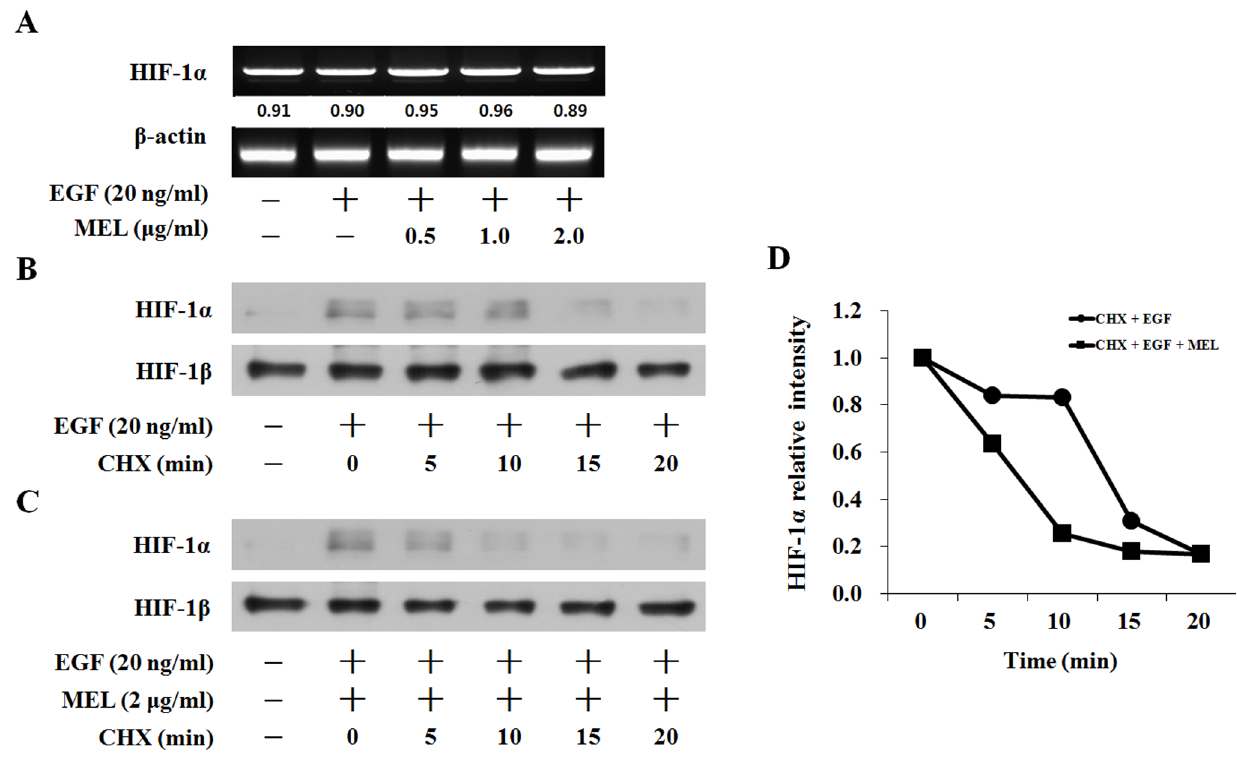
Figure 2. Melittin (MEL) inhibited the HIF-1 a expression by decreasing its stability. (A) RT-PCR analysis of HIF-1 a mRNA was carried out using total RNA prepared from CaSki cells incubated with EGF treatment for 12 h in the presence or absence of the indicated concentrations of MEL. (B) Cells were pretreated with the indicated EGF for 6 h, and then were treated to CHX time-dependent. (C) Cells were pretreated with the indicated EGF for 6 h. After 6 h, it was cotreated to MEL and CHX (10 m M) time-dependent. (D) Levels of HIF-1 a protein were determined by measuring the density of HIF-1 a protein band.